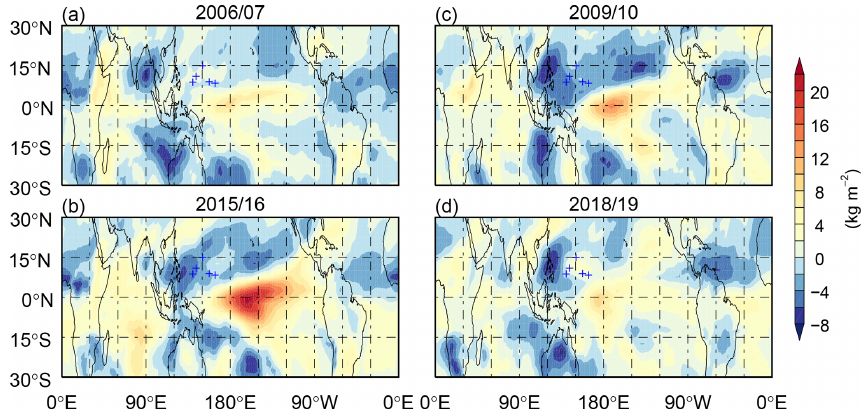
Figure 2. CWV anomalies averaged over the (a) 2006/07, (b) 2015/16, (c) 2009/10, and (d) 2018/19 winters derived from ERA5 reanalysis data. The blue pluses denote the five radiosonde stations. The four El Niño events are classified into (left) EP El Niño and (right) CP El Niño.